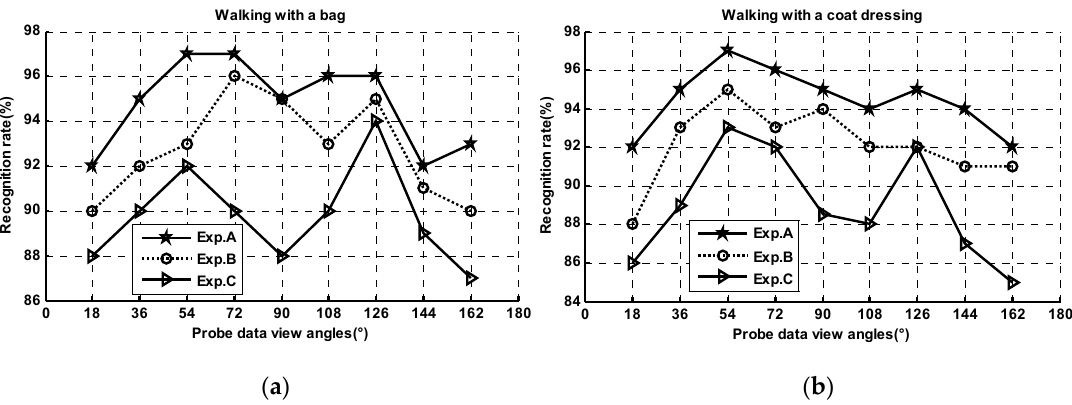
Figure 12. Rank-1 recognition (%) of GRU-GSFSL with different views’ dataset for attention model training:( a ) walking with a bag; ( b ) walking dressing a coat.